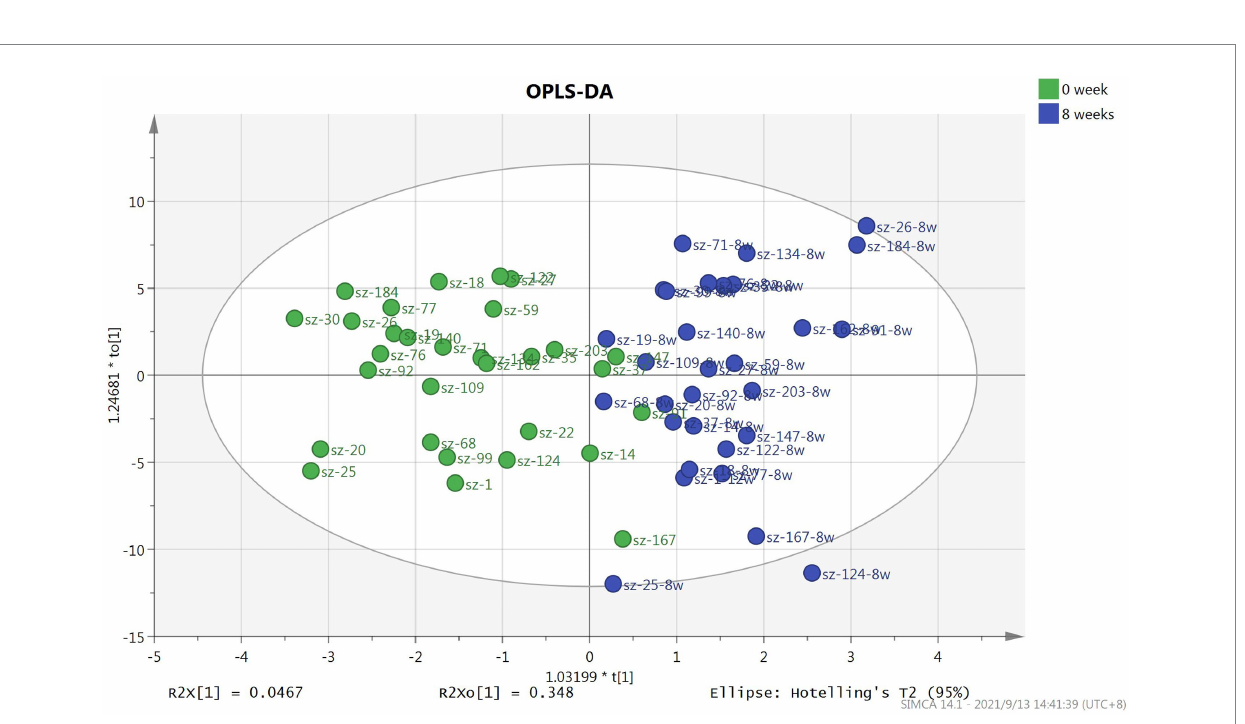
FIGURE 1 Score plot of OPLS-DA model based on plasma samples for patients with schizophrenia at baseline and after 8-week treatment with